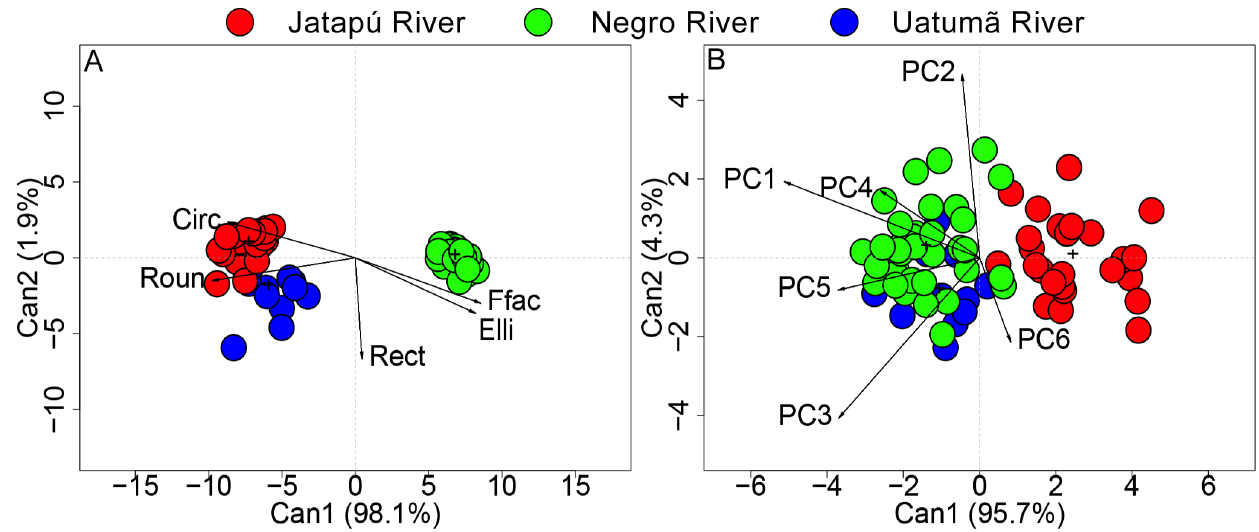
FIGURE 6 | Canonical discriminant analyses performed on shape indices ( A ) and elliptic Fourier coefficients ( B ) measured in populations of Cichla temensis from the Negro, Jatapú and Uatumã rivers. The vectors indicate the direction of increase in the various measured characteristics: Roundness (Roun), Rectangularity (Rect), Ellipticity (Elli), Circularity (Circ), form factor (Ffac); PC1 to PC6 correspond to the significant scores of the PCA performed on the Fourier